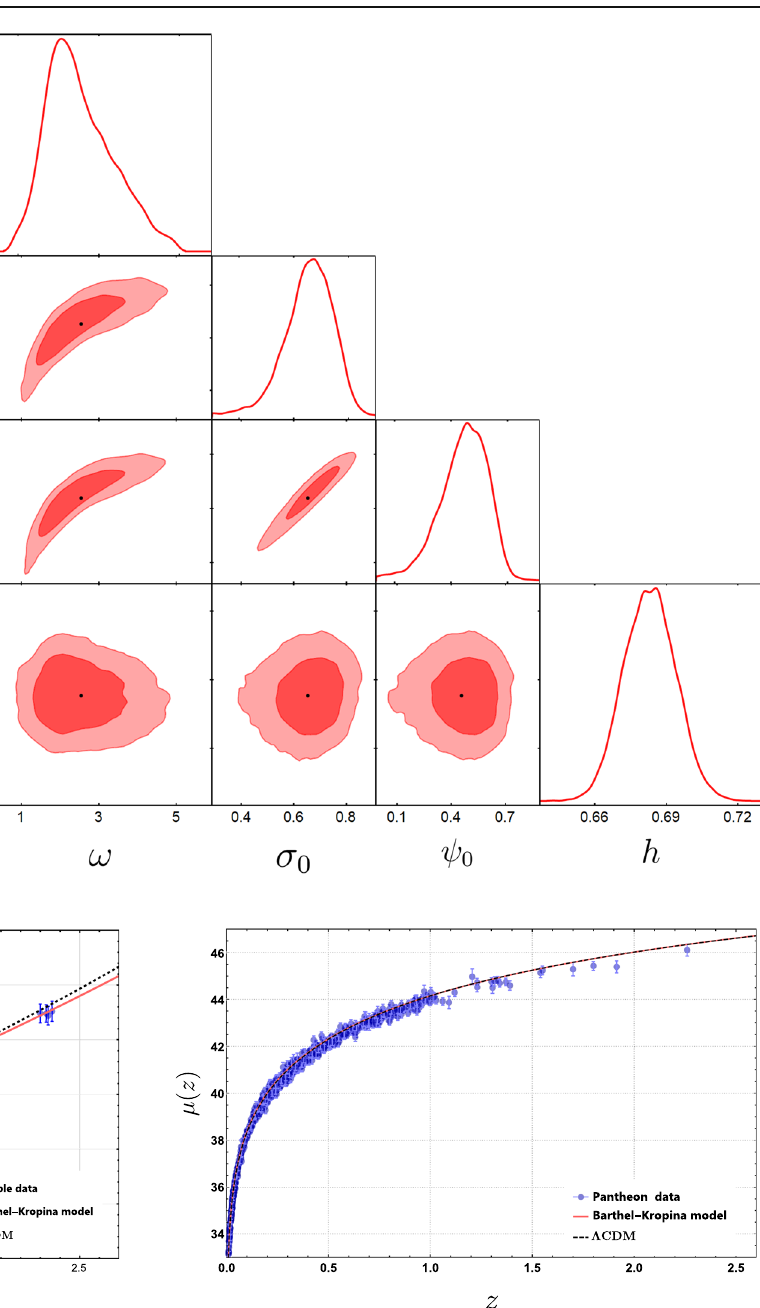
Fig. 3 The evolution of the distance modulus μ( z ) of the Barthel– Kropina dark energy model, and of the (cid:2) CDM model in terms of the redshift z against the Pantheon